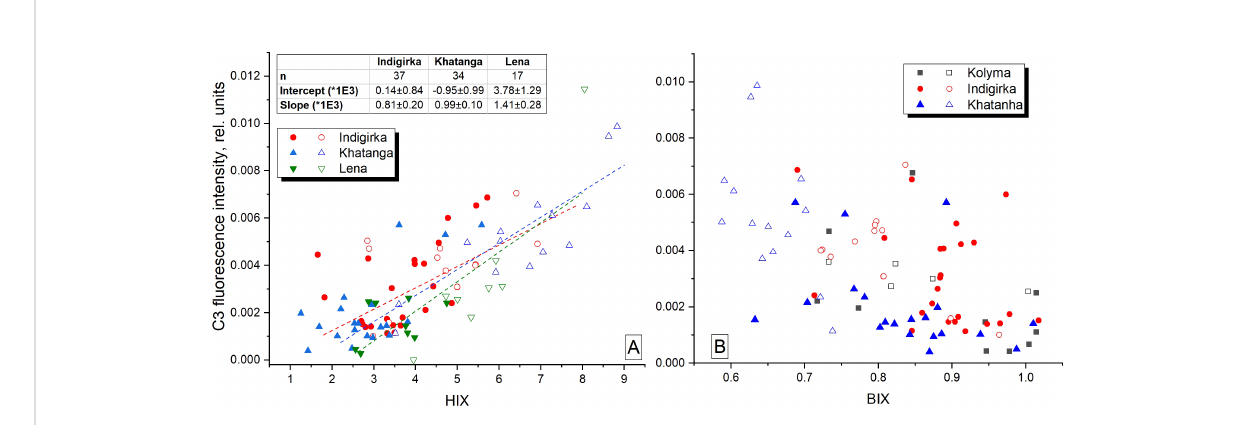
FIGURE 11 Fluorescence intensity of C3 against HIX and BIX. Filled symbols indicate the data obtained outside the river plume regions with salinity above